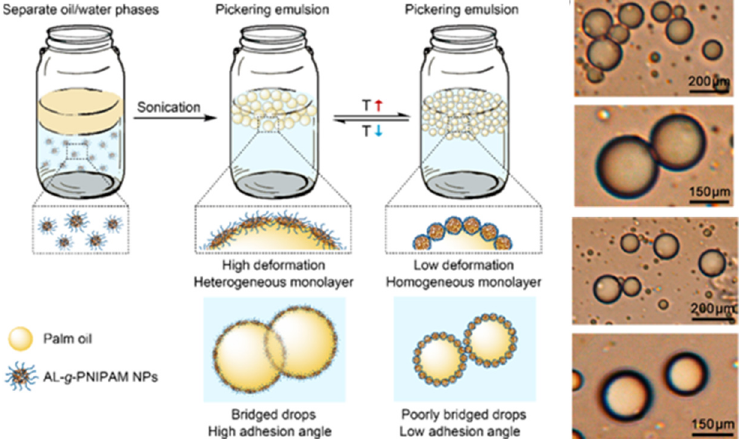
Figure 8. AL- g -PNIPAM NPs stabilized palm oil emulsions for heat-controlled release of photo- sensitive and low water-soluble drugs. Reprinted with permission from Ref. [57]. Copyright 2019 American Chemical Society.